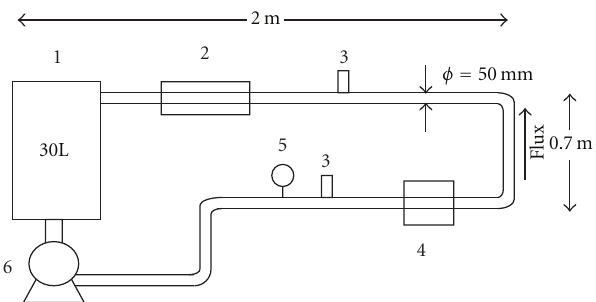
Figure 1: Looping diagram. (1) Reservoir containing the fluid; (2) support for the cylinders; (3) thermocouple; (4) flow meter; (5) pressure sensor; (6) centrifugal